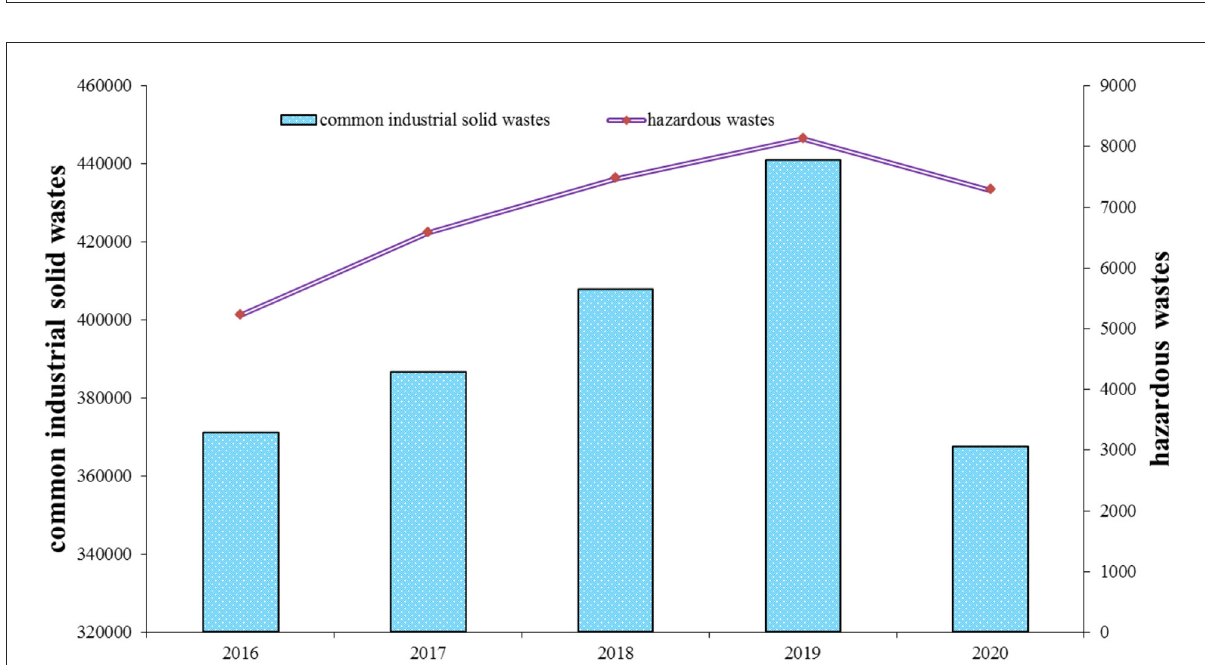
FIGURE3 Generation of industrial solid wastes in China during 2016–2020 (10000 tons). Source: The author obtained the information from the China Statistical Yearbook on Environment .